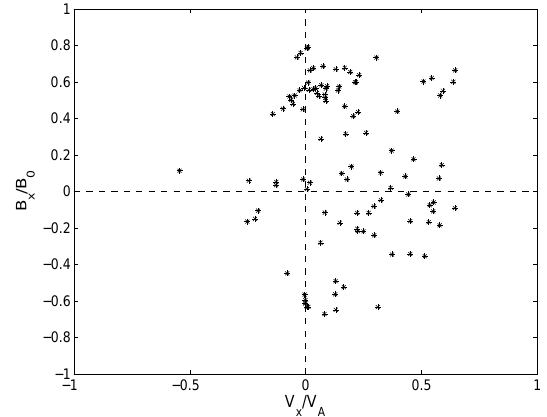
Figure 5. A scatterplot of locations of the most efficient energiza- tions as a function of B x and V x . B x and V x have been normalized by the asymptotic magnetic field B 0 and Alfven speed based on B 0 and n 0 ; here n 0 is the plasma density in the central current sheet. Data points with top 3% electron acceleration efficiency for each event are